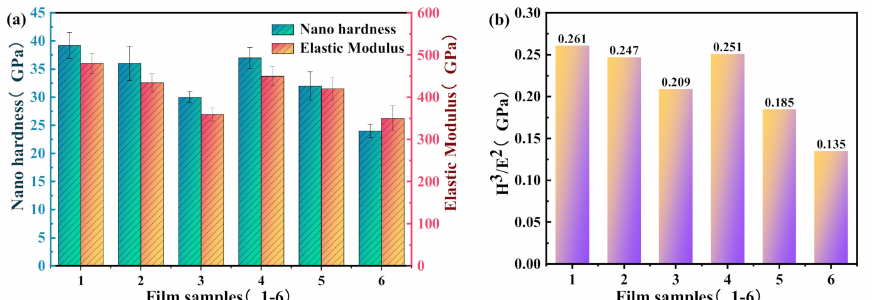
Figure 10. Mechanical properties of TiN/Si 3 N 4 film: ( a ) nano-hardness and elastic modulus. ( b ) H 3 /E 2 ratio.